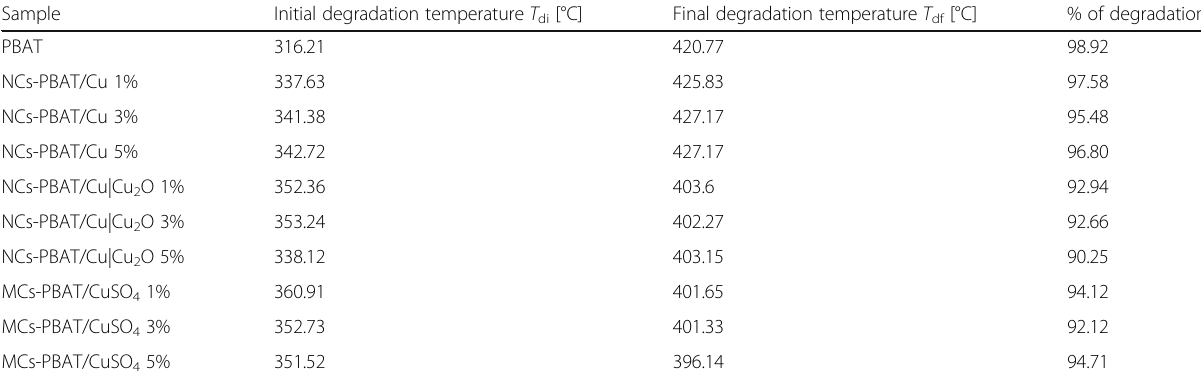
Table 3 Degradation temperature of PBAT, NCs-PBAT/Cu, NCs-PBAT/Cu|Cu 2 O, and MCs-PBAT/CuSO 4